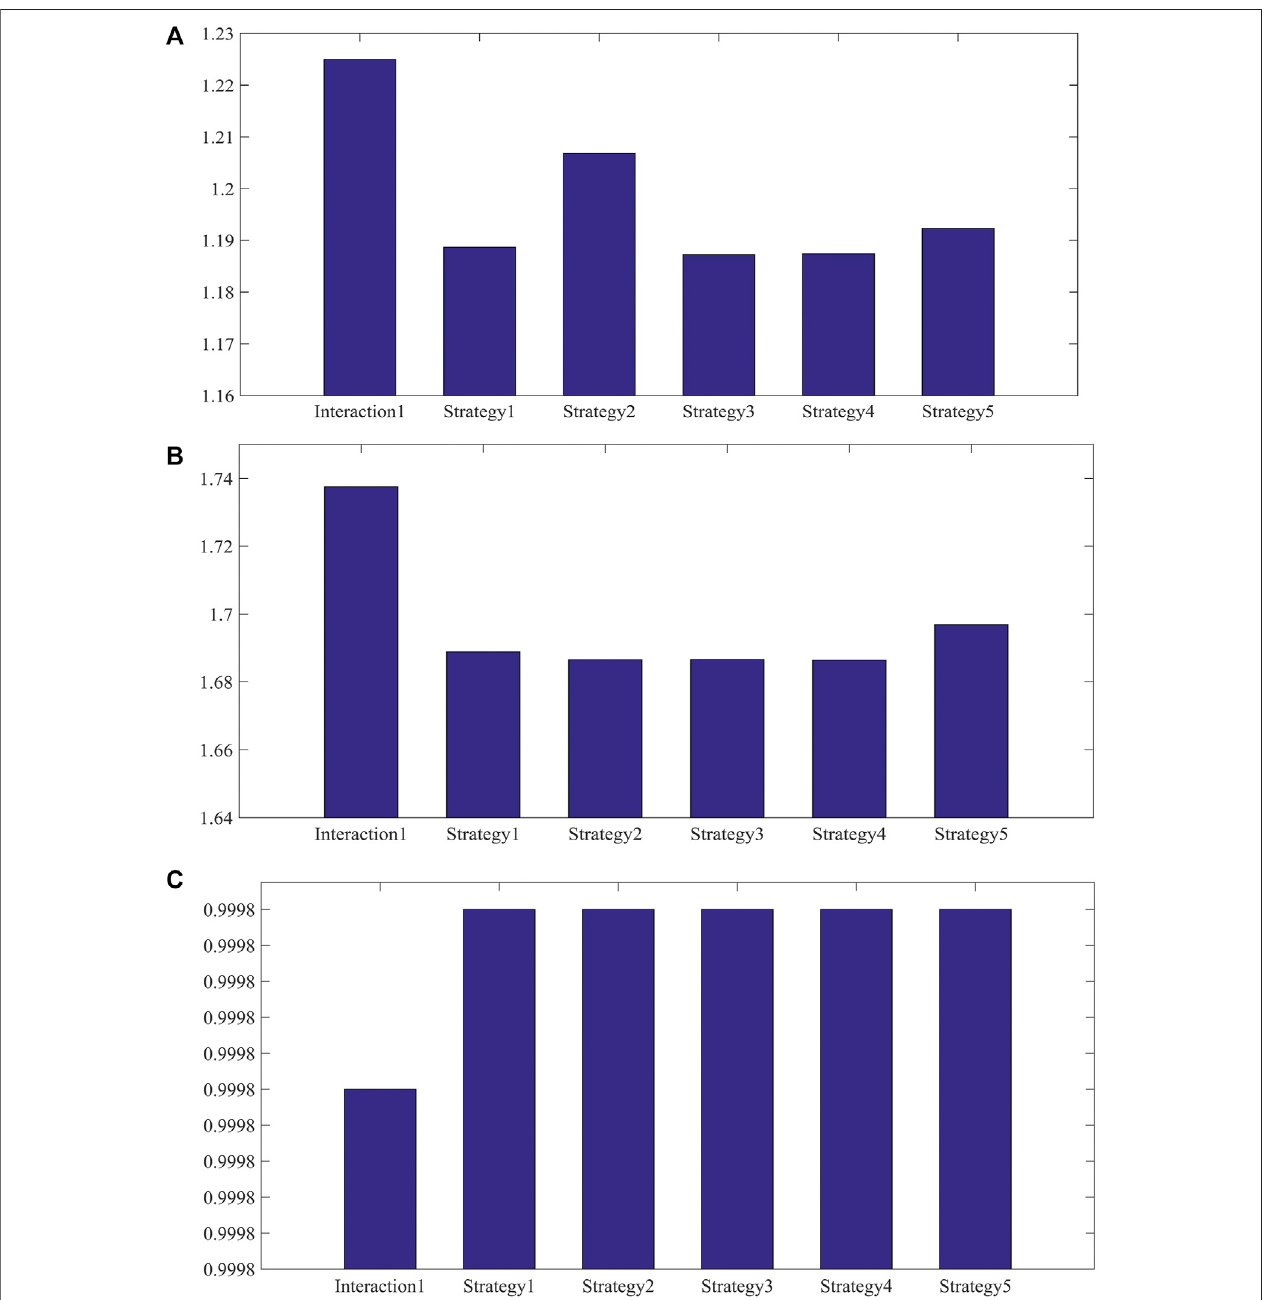
FIGURE 8 | (A) Values of SAIFI index. (B) Values of SAIDI index. (C) Values of ASAI